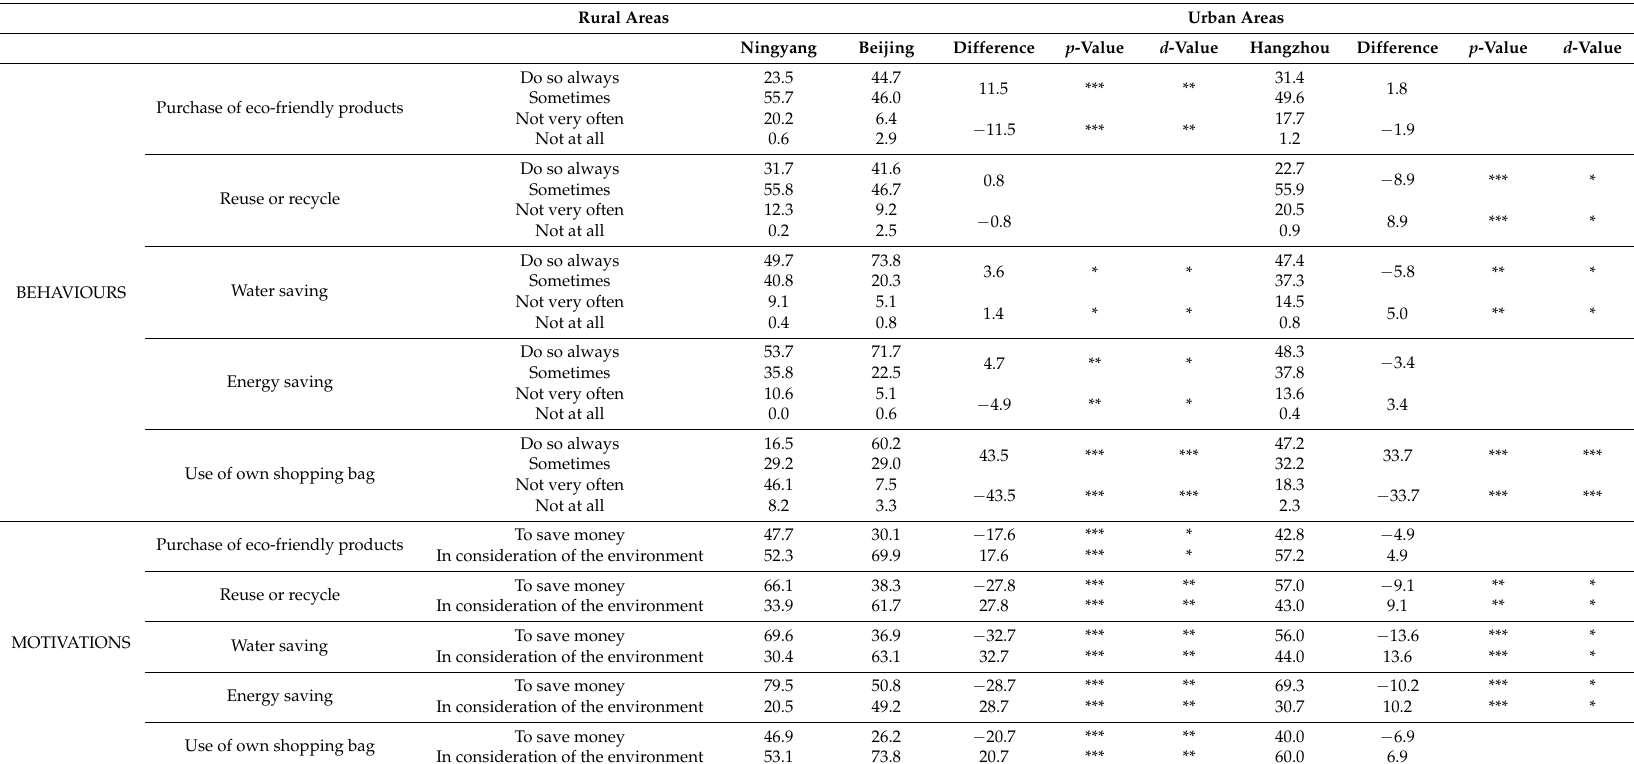
Table 2. Relative frequencies and proportion test results of responses to behaviours and motivations items (Unit: